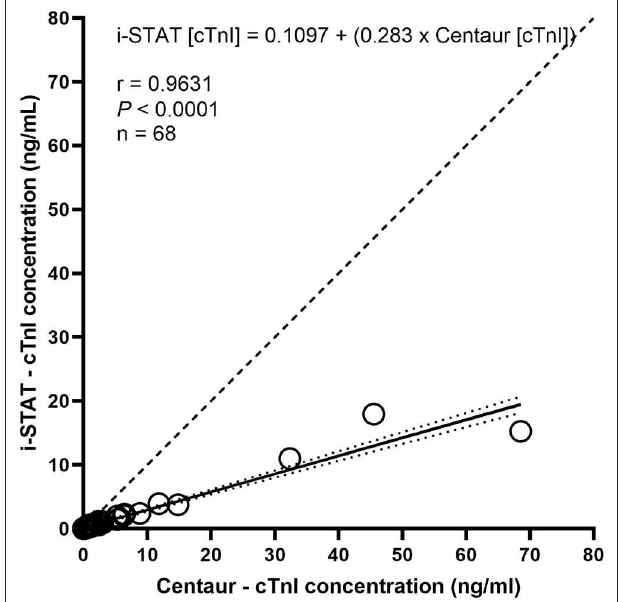
FIGURE 1 | Linear regression of cTnI concentrations as determined by i-STAT and Centaur analyzers. Circles indicate concentrations as determined by i-STAT (Y axis) and Centaur (X axis). The solid line represents regression line with dotted lines recommending 95% confidence intervals for the regression line. The dashed line represents a line of